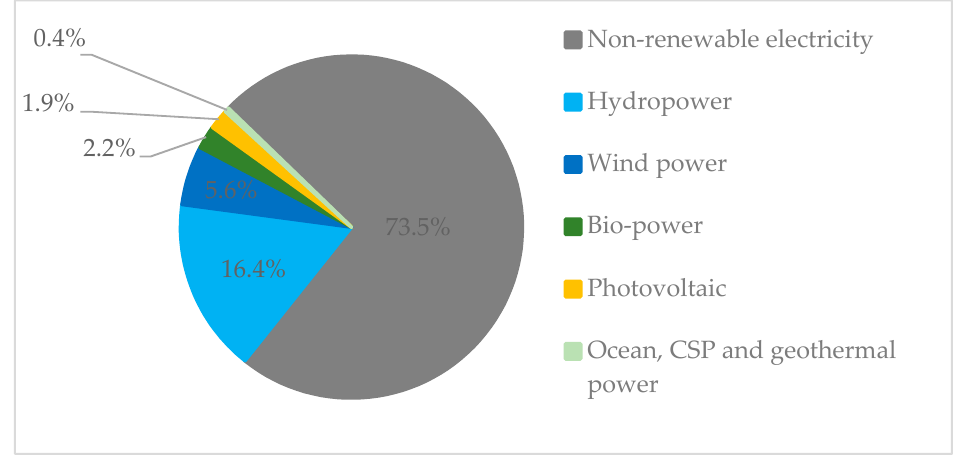
Figure 1. Estimated renewable energy share of global electricity production, 2017, based on [17].